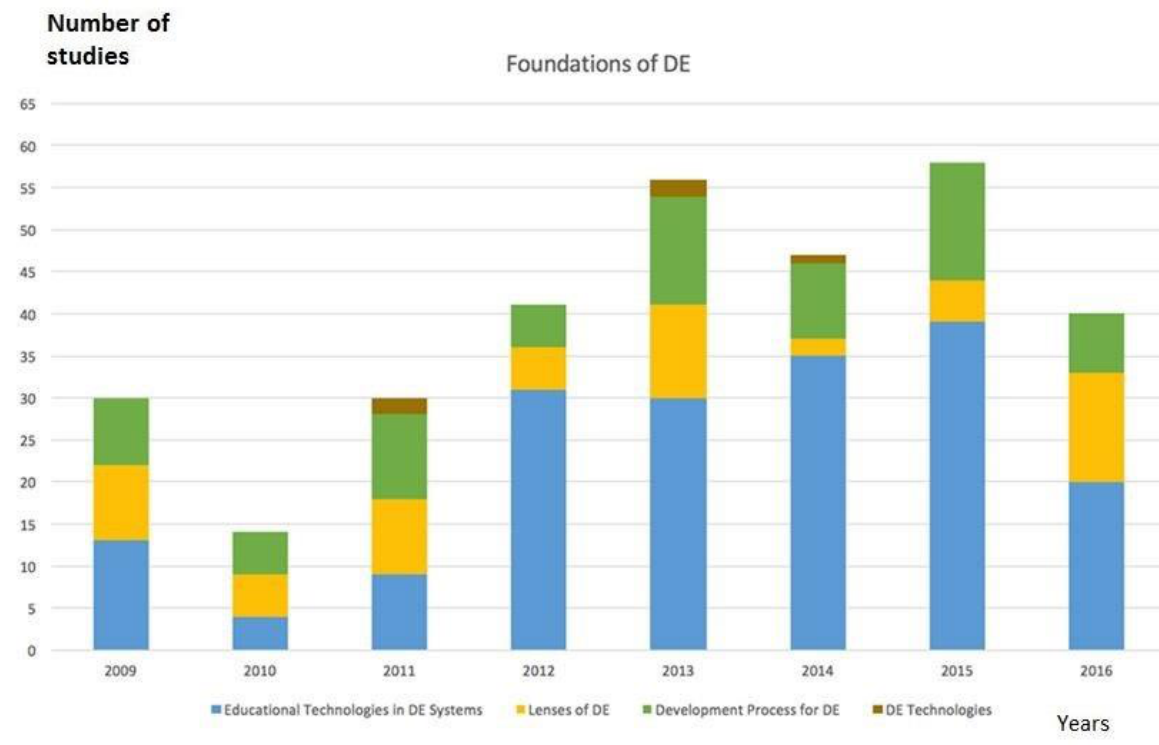
Figure 5. Trends in the main theme of Foundations of